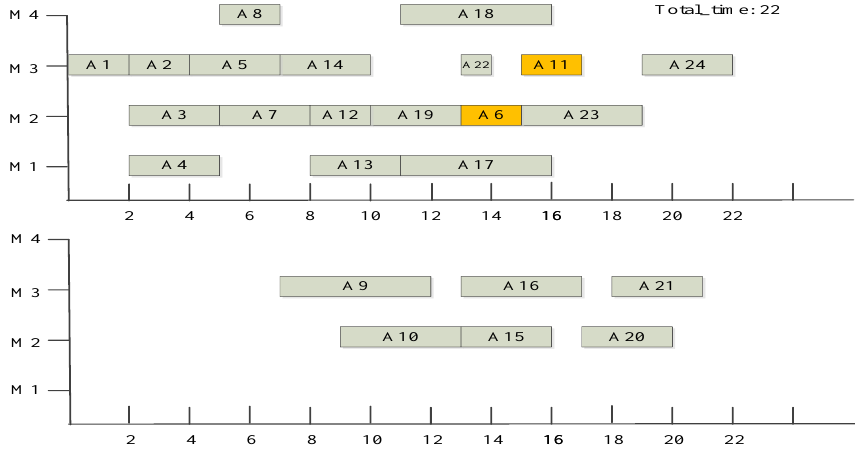
Figure 6. Gantt chart of scheduling results of the algorithm in this paper.